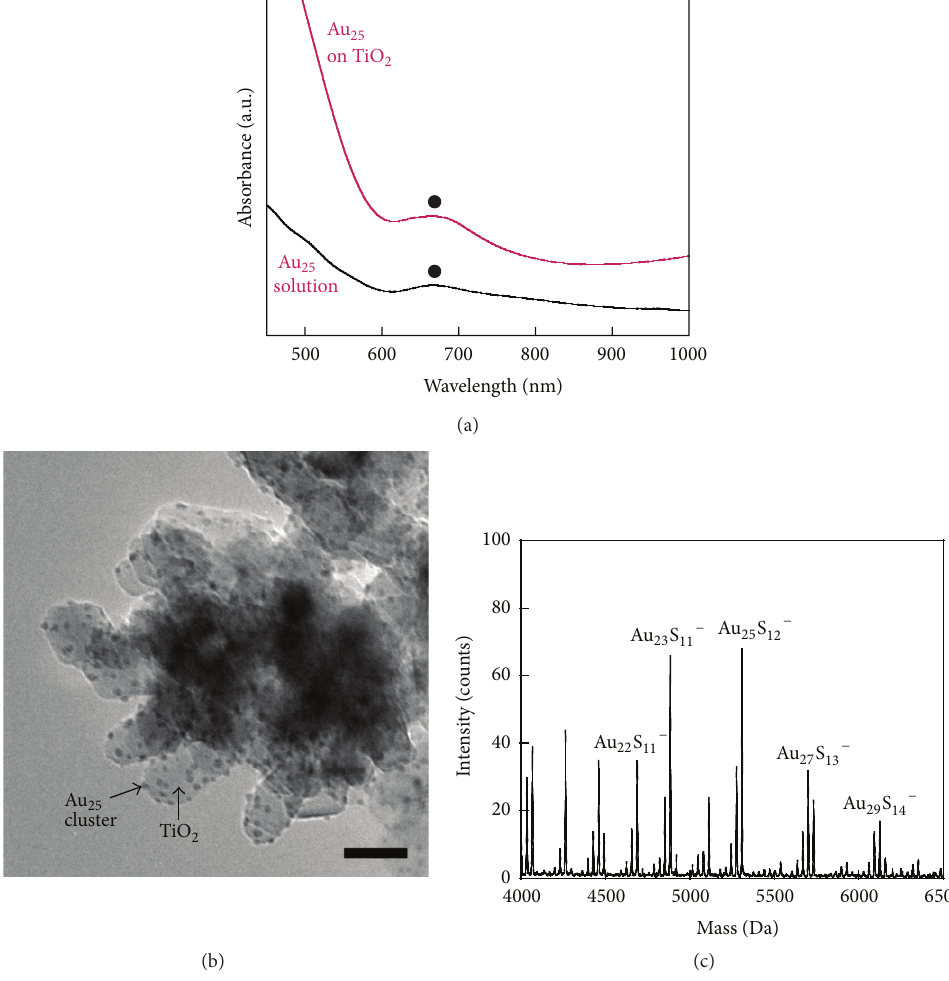
Figure 1: (a) Absorption spectrum of Au 25 clusters in water, (b) TEM image of Au 25 clusters on TiO 2 particles (scale bar is 20nm), and (c) LDI-MS spectrum of Au 25 clusters on TiO 2 particles (negative ion mode).